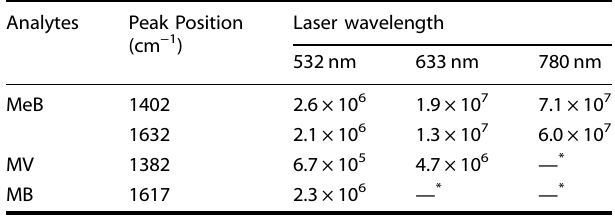
Table 1. Calculated EF values for MeB, MV, and MB detection irradiated by different